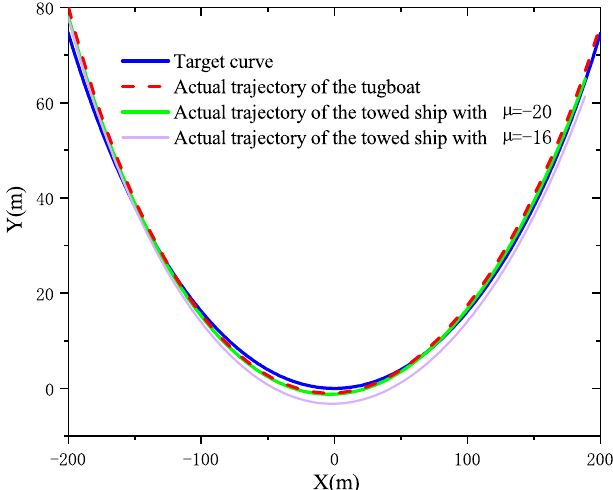
Figure 8. Actual motion trajectory curve under the uncertain factor d ( t )